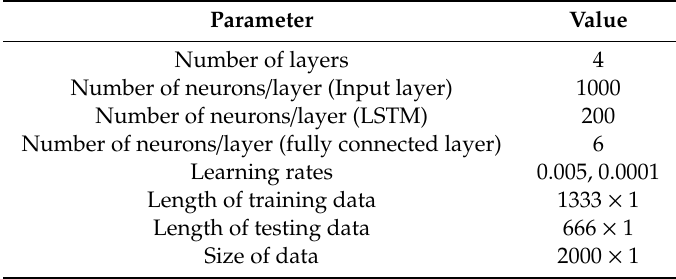
Table 2. LSTM channel estimation (CE) simulation parameters.